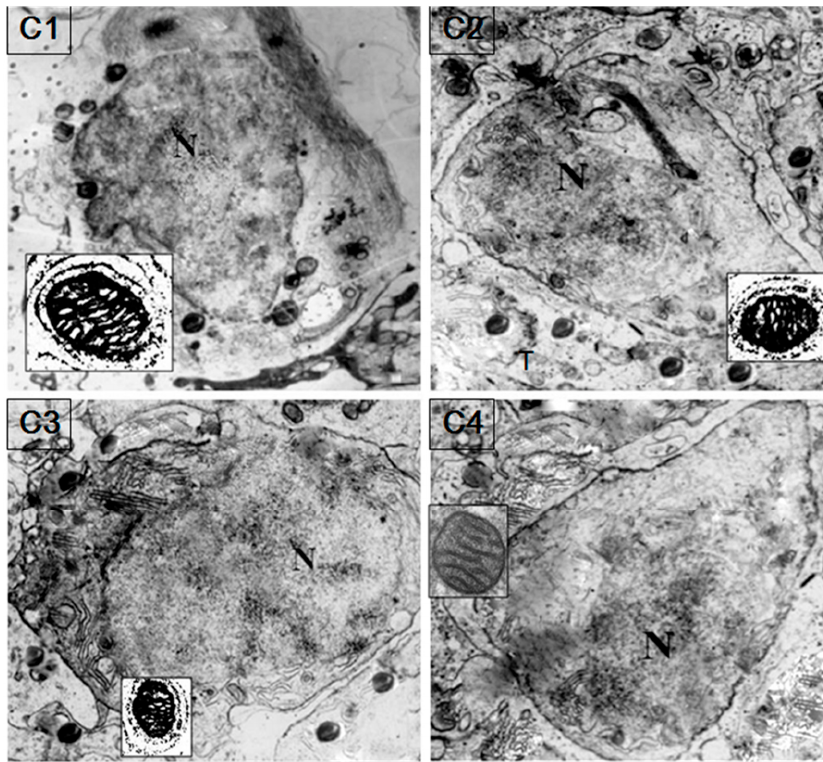
Figure 6. Colloidal gold immunocytochemical detection of HSP60/HSP10 in the sperm mitochondria. Colloidal gold particles are mainly present in the sperm mitochondrial inner membranes. The black dots show the immunolabeled mitochondria matrix. The little box shows the magnified figure of the immunolabeled mitochondria. N: nucleus. ( C1 ): secondary spermatocyte incubated with anti-HSP60 ( × 5600); ( C2 ): secondary spermatocyte incubated with anti-HSP60 ( × 5600); ( C3 ): secondary spermatocyte incubated with anti-HSP10 and anti-HSP60 ( × 5600); ( C4 ): secondary spermatocyte for the negative control with omission of the first antibody ( ×